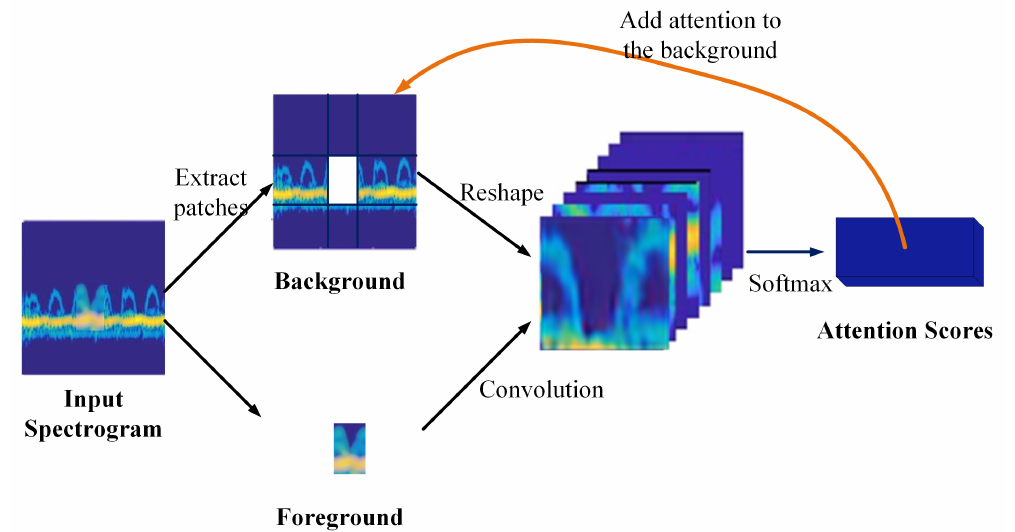
Figure 4. Contextual attention layer. Several patches (3 × 3) are extracted from the background and reshaped to the size of the missing part feature maps after two downsampling